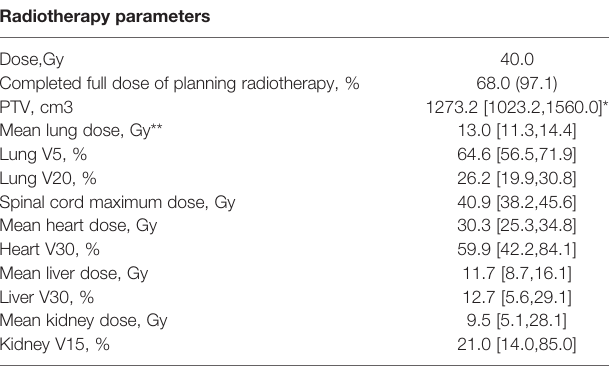
TABLE 2 | Radiotherapy Parameters. Radiotherapy parameters Dose,Gy 40.0 Completed full dose of planning radiotherapy, %